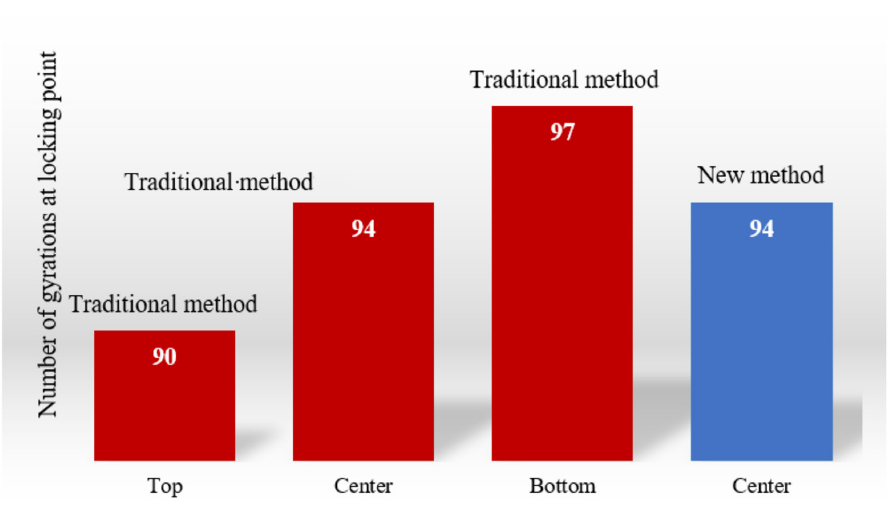
Figure 11. Locking point histogram.